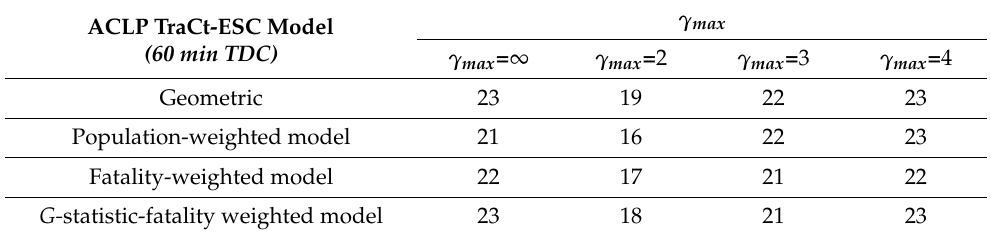
Table 2. Number of facilities chosen as solutions for TraCt-ESC models with γ max